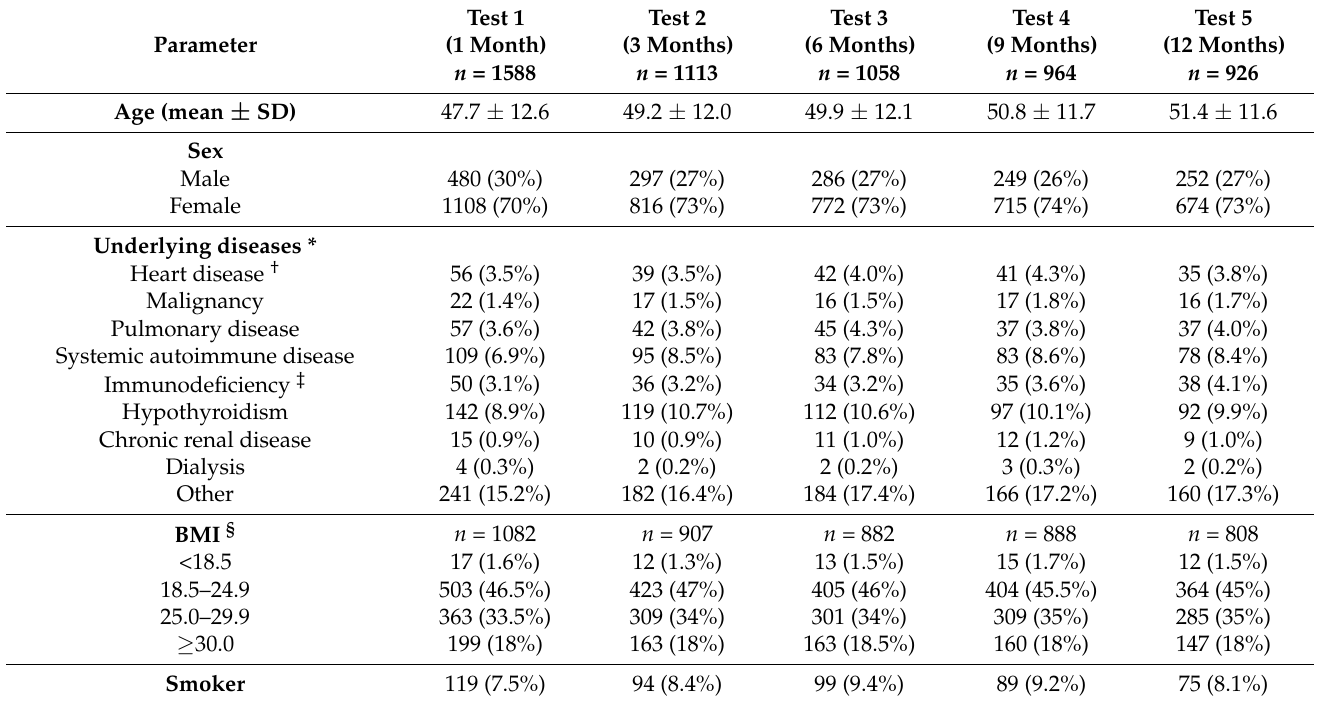
Table 1. Participant characteristics for all five serology tests.